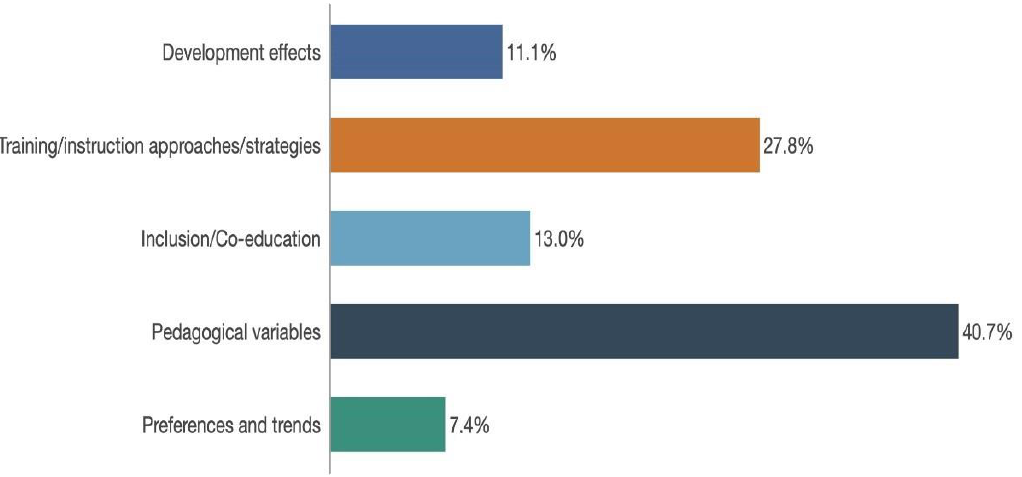
Figure 4. Weighting of the Main Objectives Envisaged; Source: Compiled by author.